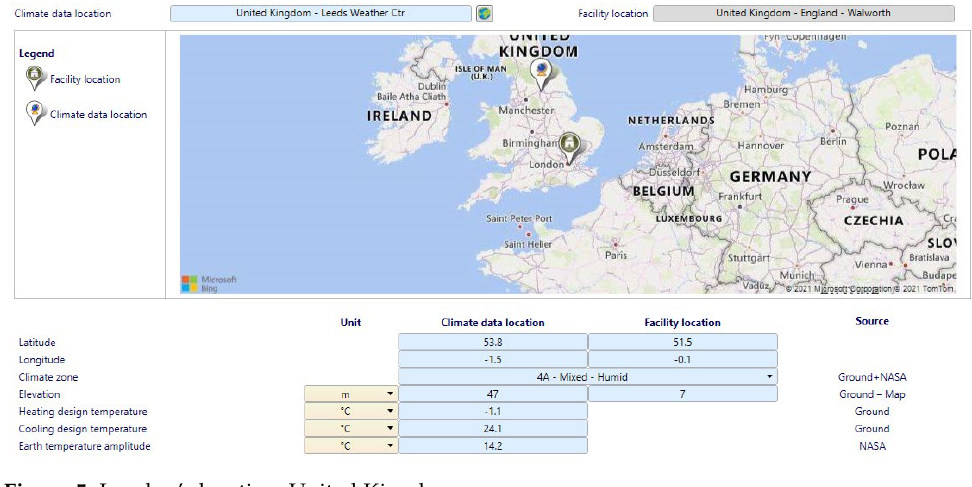
Figure 5. London’s location, United Kingdom.